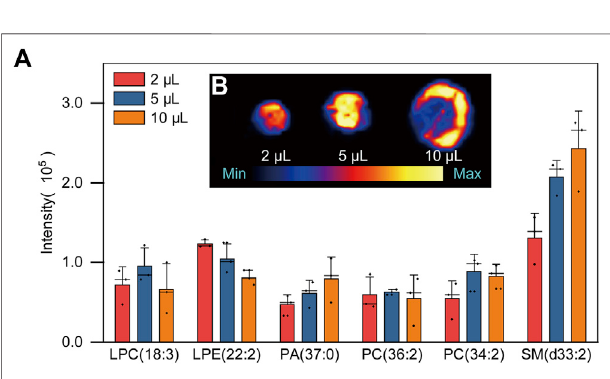
FIGURE 2 | (A) Bar chart of PLs signal intensities in three different volumes of plasma samples: 2, 5 and 10 μ l (B) Two-dimensional distribution diagram of SM (d33: 2) of DPSs in three different sample